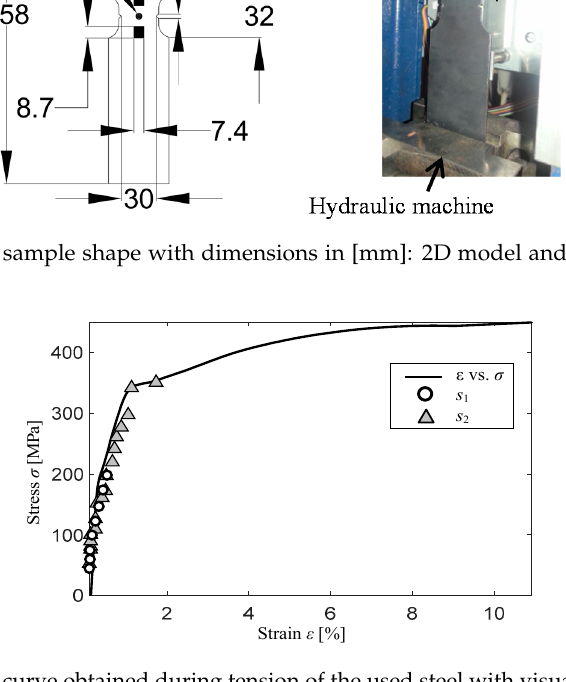
Figure 4. Stress-Strain curve obtained during tension of the used steel with visualization of successive measuring points for two presented samples s 1 and s 2 .